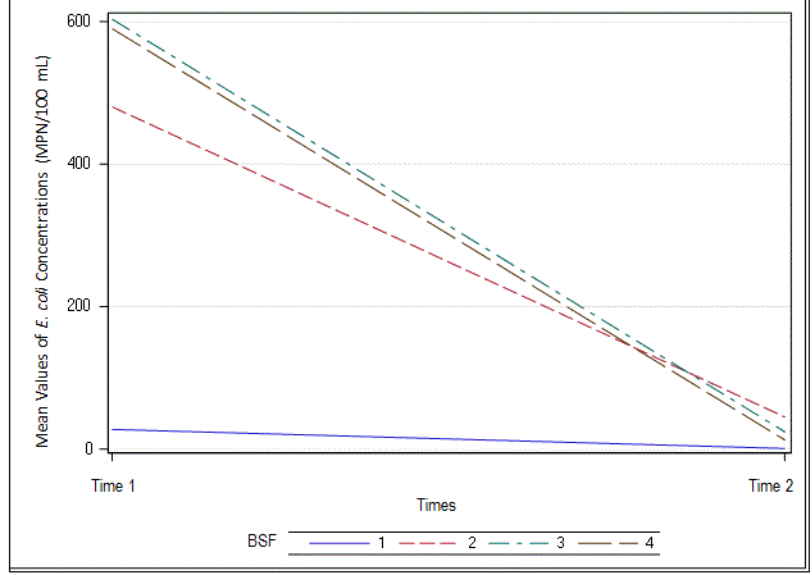
Figure 10. Analysis of variance for repeated measures by mixed models of E. coli .